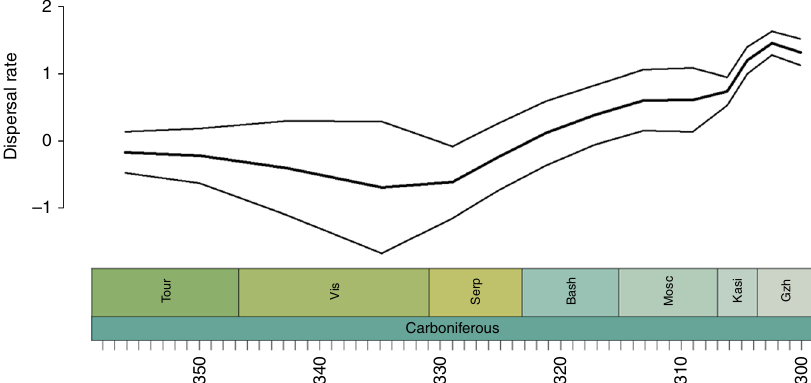
Fig. 4 Carboniferous dispersal rates of all Tetrapoda, using the regional divisions of Dunne et al. 41 . Thick lines represent the mean of the rates obtained from each stochastic mapping iteration. The thinner lines represent a standard error above